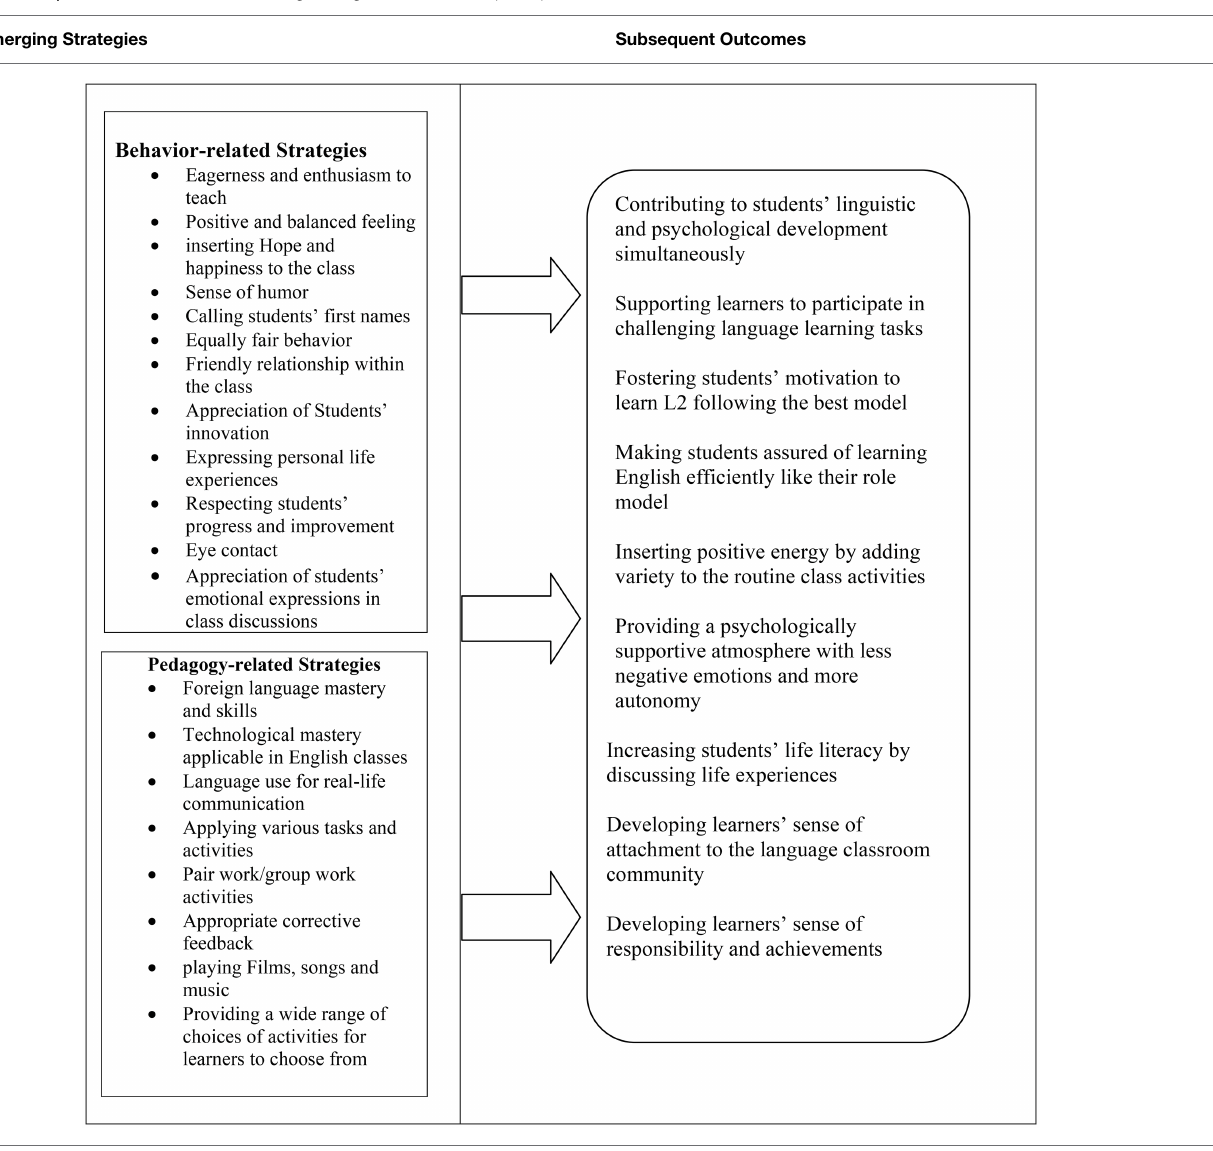
TABLE 1 | Teachers’ emotional scaffolding strategies in the student participants